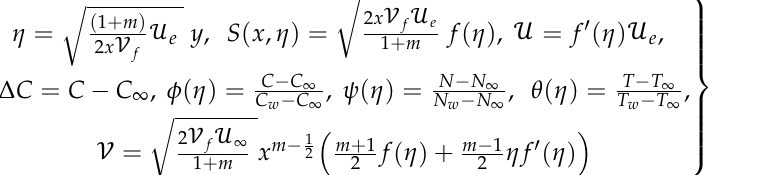
(cid:114) 2 = Figure 1. Physical con fi guration of Falkner–Skan fl ow model.